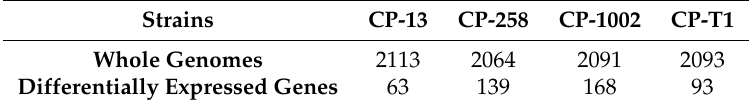
Table 3. Sizes of the gene expression